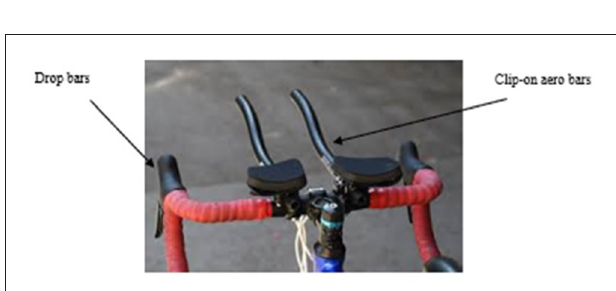
FIGURE 2 | Representation of drops and aerodynamic